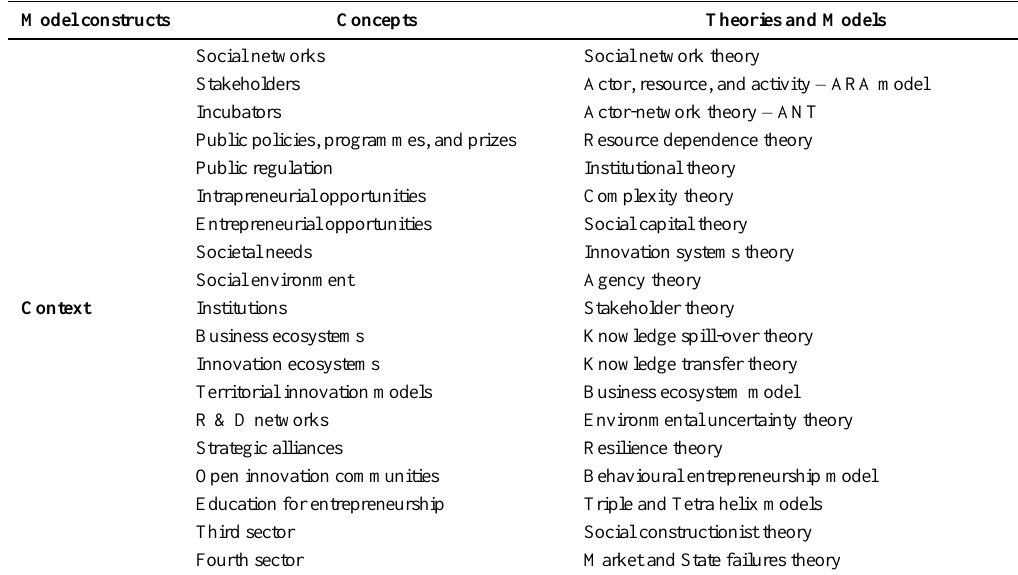
Table 2. Constructs, concepts, theories, and